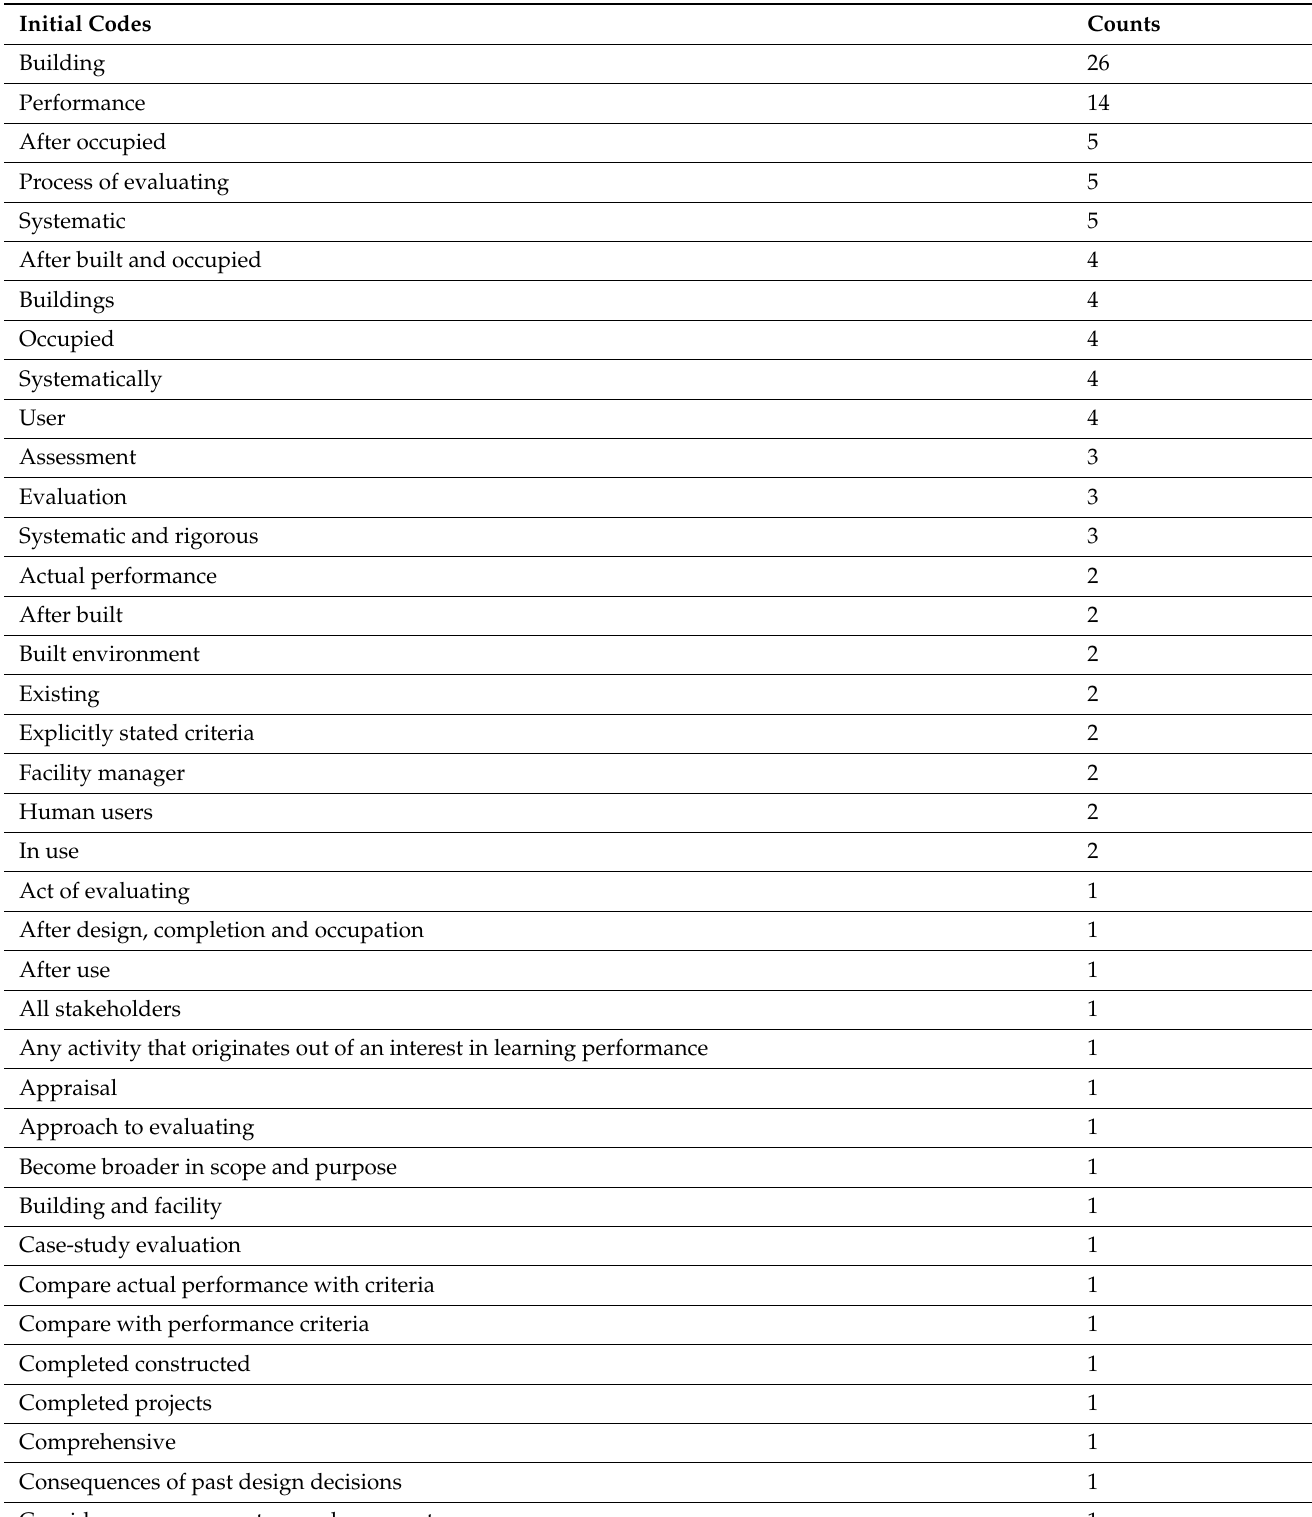
Table A2. Codes Count of the Open Coding of the POE